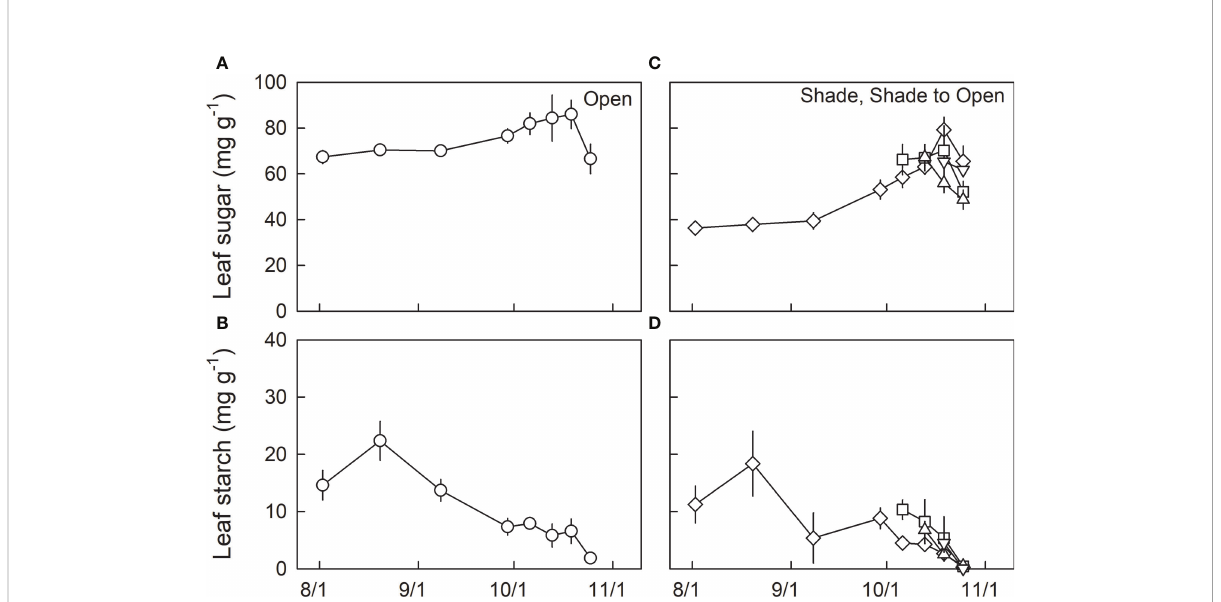
FIGURE 4 Seasonal changes in dry mass-based leaf sugar (A, C) and leaf starch content (B, D) in leaves of fullmoon maple grown under open (H0: circle), shade (L0: diamond), and shade to open (LH1: square, LH2: triangle up, and LH3: triangle down) conditions. Seedlings grown under shade were